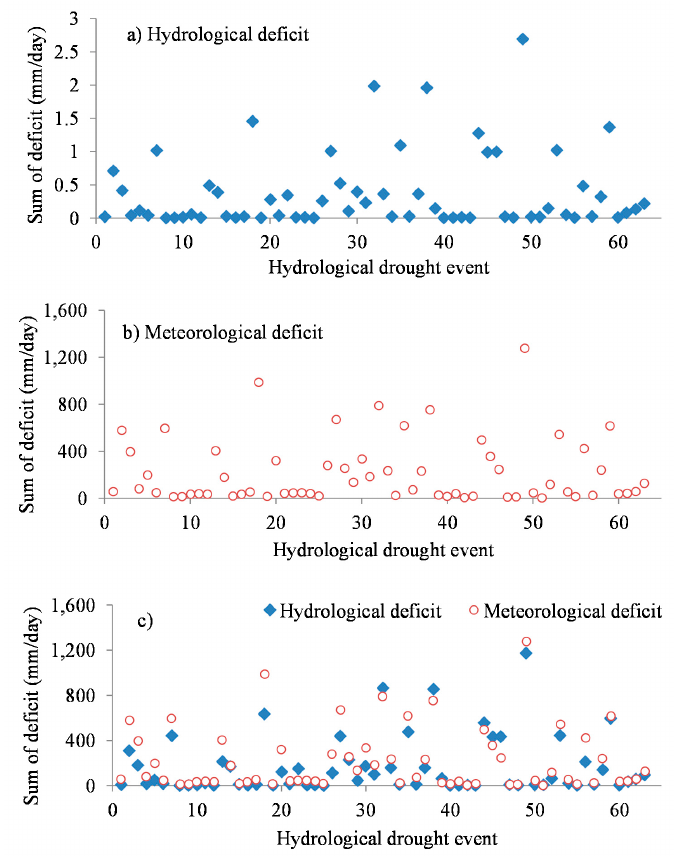
Figure A10. ( a ) Hydrological drought; ( b ) sum of meteorological deficit; and ( c ) comparison of the sum of hydrological and meteorological deficits.